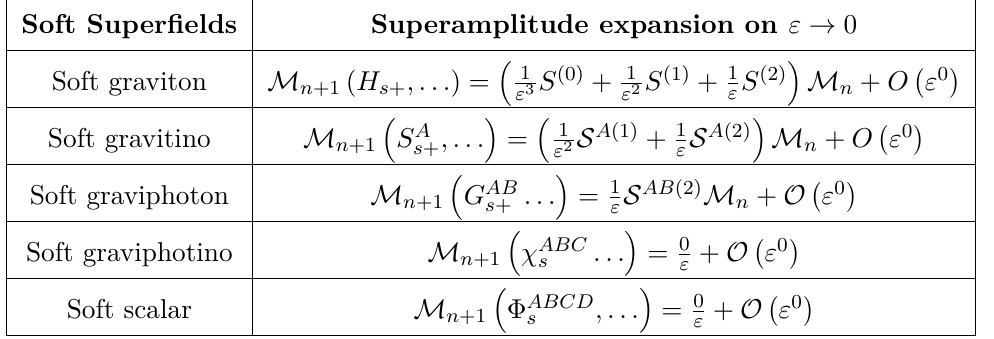
Table 15 . Various soft limit expansion of the